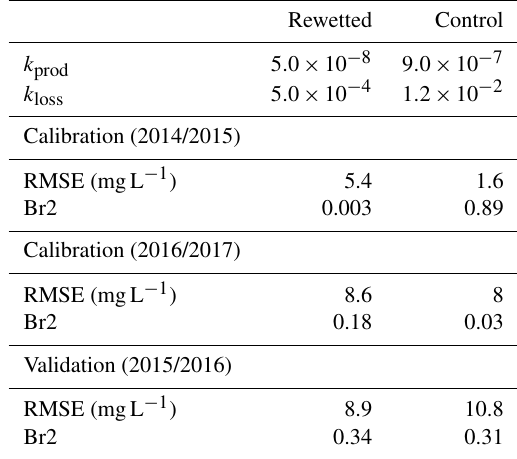
Table 5. Calibrated parameters and efficiency of the DOC model. Rewetted